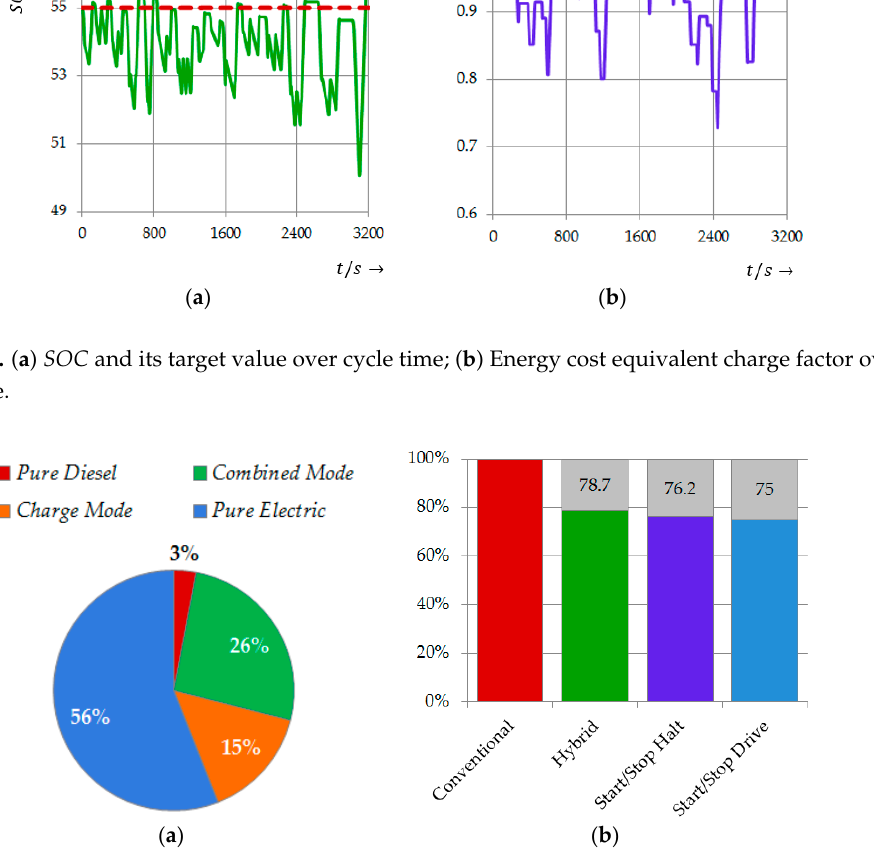
Figure 11. ( a ) Percental proportion of operation modes during acceleration and cruising (hybrid without Start/Stop ); ( b ) Overview over percental reductions of corrected fuel consumption.